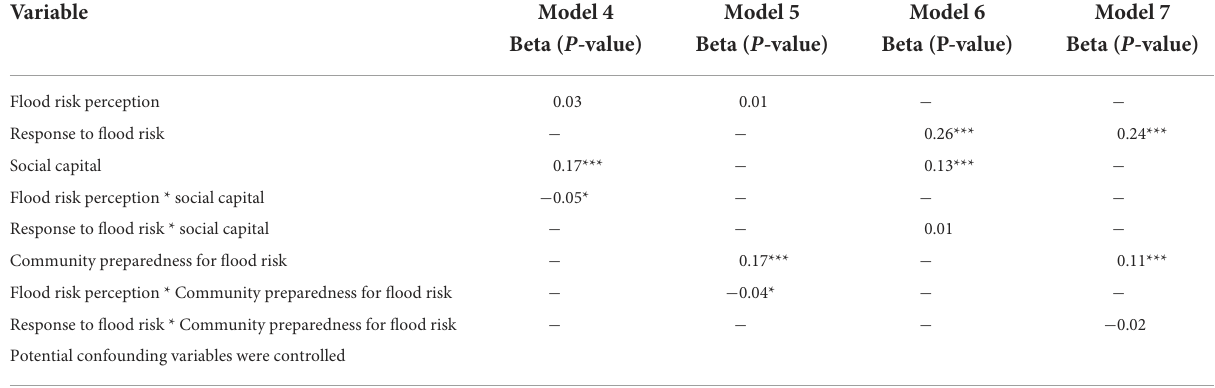
TABLE 4 The moderating effects of social capital and community preparedness for flood risk ( N = 2,283).